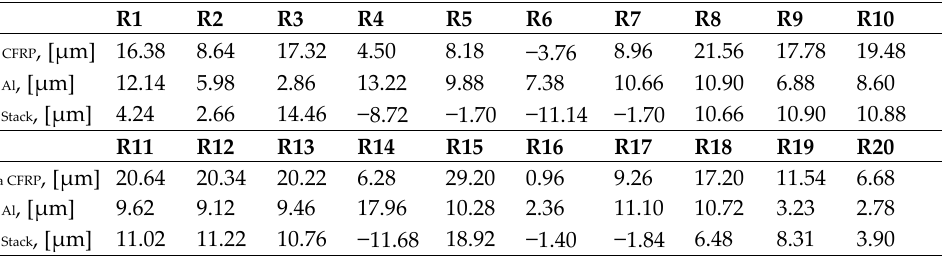
Figure 18. Hole diameter errors between stack-up materials for all runs.